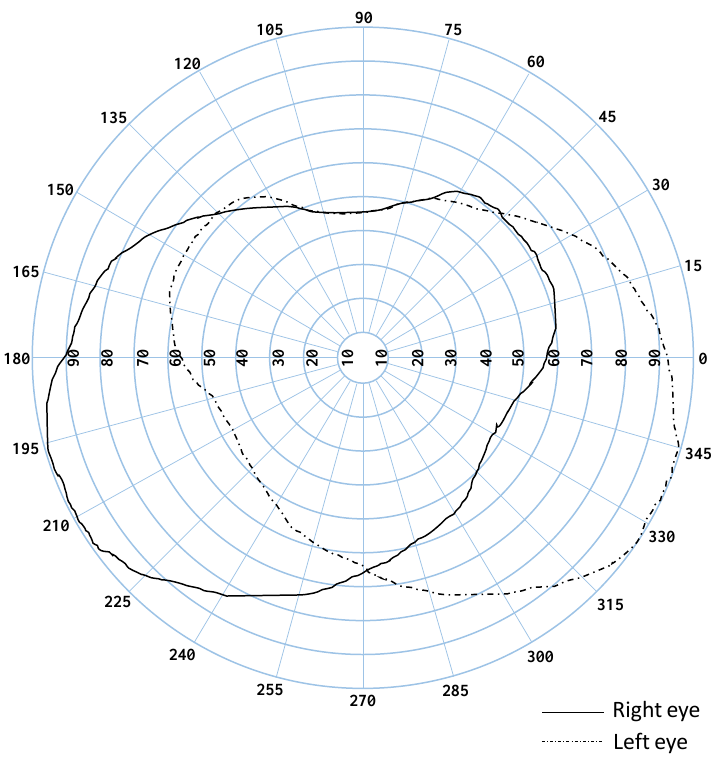
Figure 7. Areas of vision